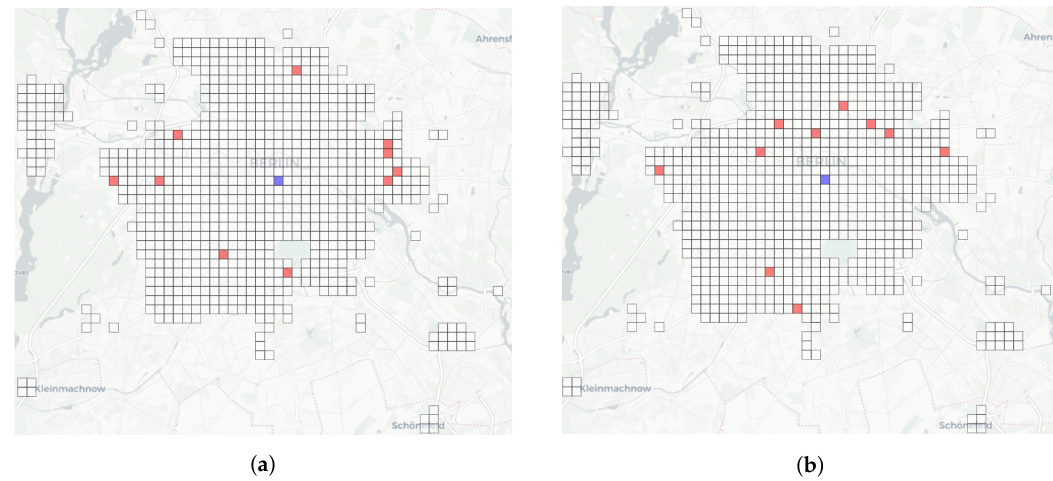
Figure 8. Cell catering and entertainment : Dynamic neighborhood on Monday morning and on Monday afternoon. ( a ) morning; ( b ) afternoon.